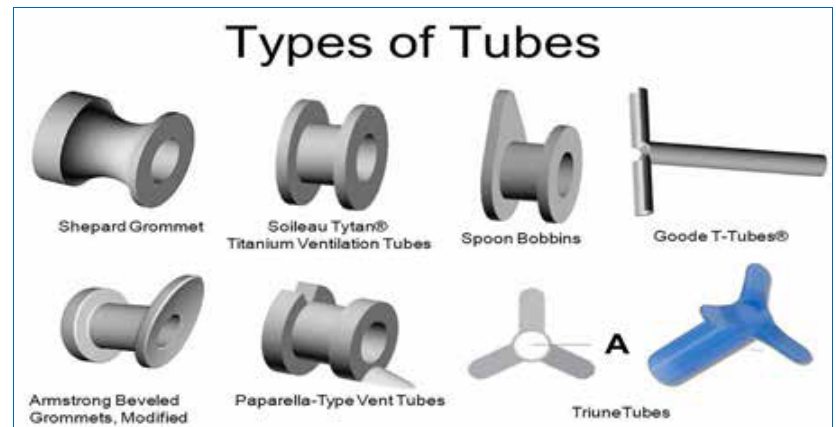
Figure 2: Types of grommets short and long term